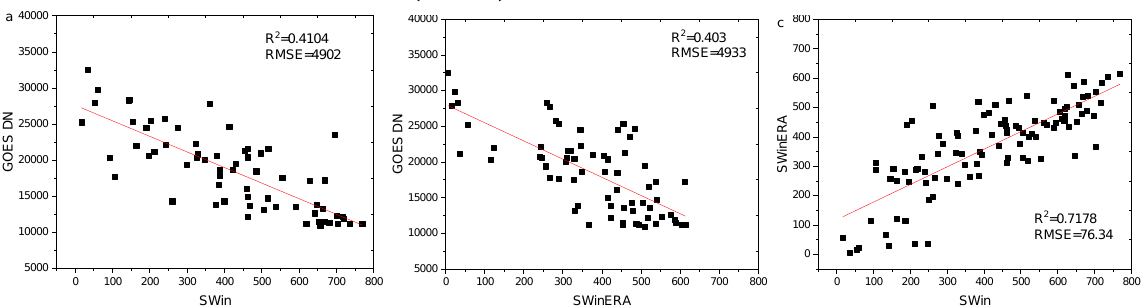
Figuer.2 . Comparison of satellite based DN values with in-situ measurement Shortwave radiation input in 12:00. GOES DN is the GOES-13 visible band’s record. SWinERA is the ERA reanalysis downward shortwave radiation and SWin is the flux tower in-situ measurement downward shortwave radiation (in W/m2).